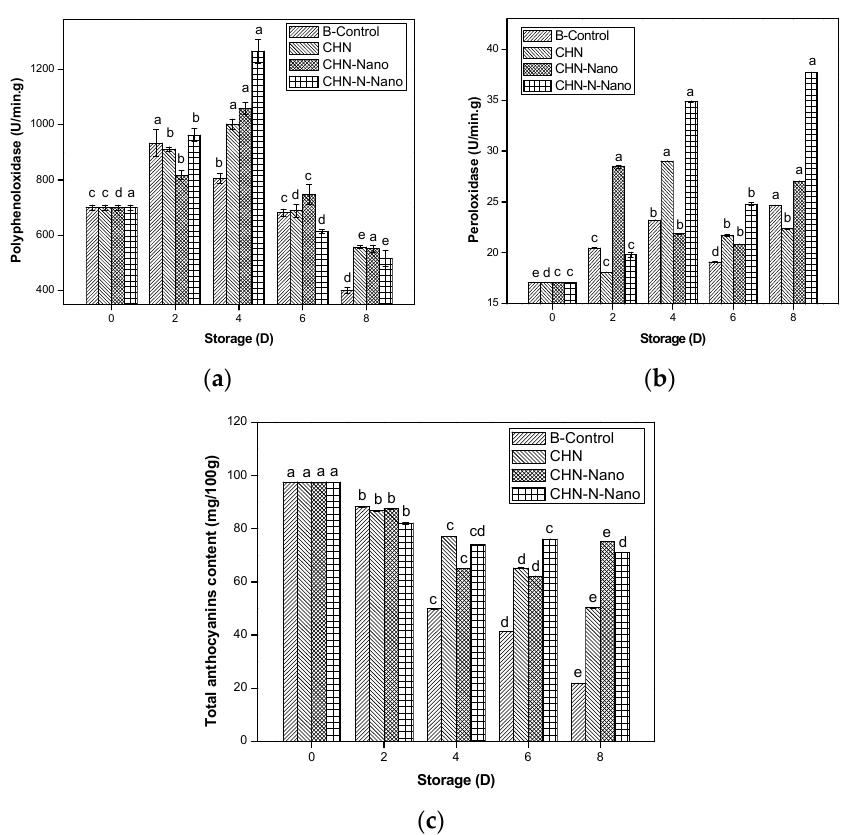
Figure 6. Effects of coating treatments on oxidation browning enzyme ( a ) (Polyphenoloxidase (PPO), ( b ) Peroxidase (POD)) and total ( c ) Anthocyanin content (TAC). Blueberry fruits contain several types of anthocyanin components, such as petunidin, cyanidin, malvidin delphinidin, and peonidin [17]. Anthocyanin contents were reduced during the whole storage period, due to phenolics catalyzed oxidation by (PPO, POD) [31]. At the end of the whole storage,